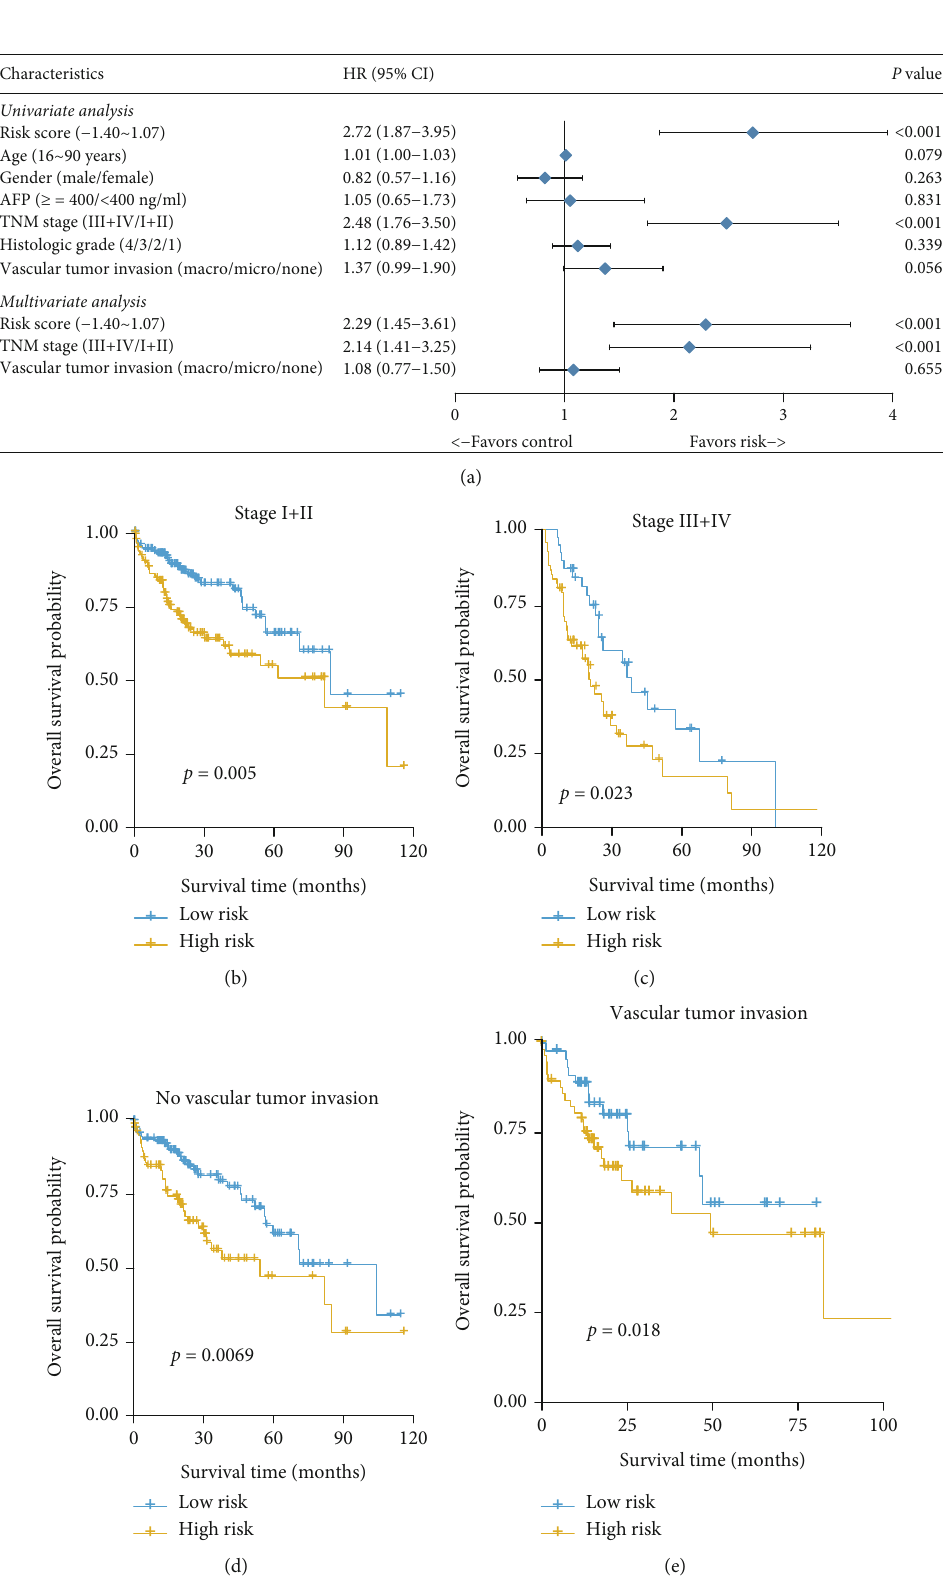
Figure 5: Risk scores are an independent predictor of patient outcomes. Forest plots corresponding to univariate and multivariate Cox regression analyses of the relationship between HCC patient OS and various clinical indicators and risk scores (a). Patients were classi fi ed based upon whether they exhibited vascular invasion and based upon their TNM stage. Risk score performance in each patient subcategory was then assessed (b –